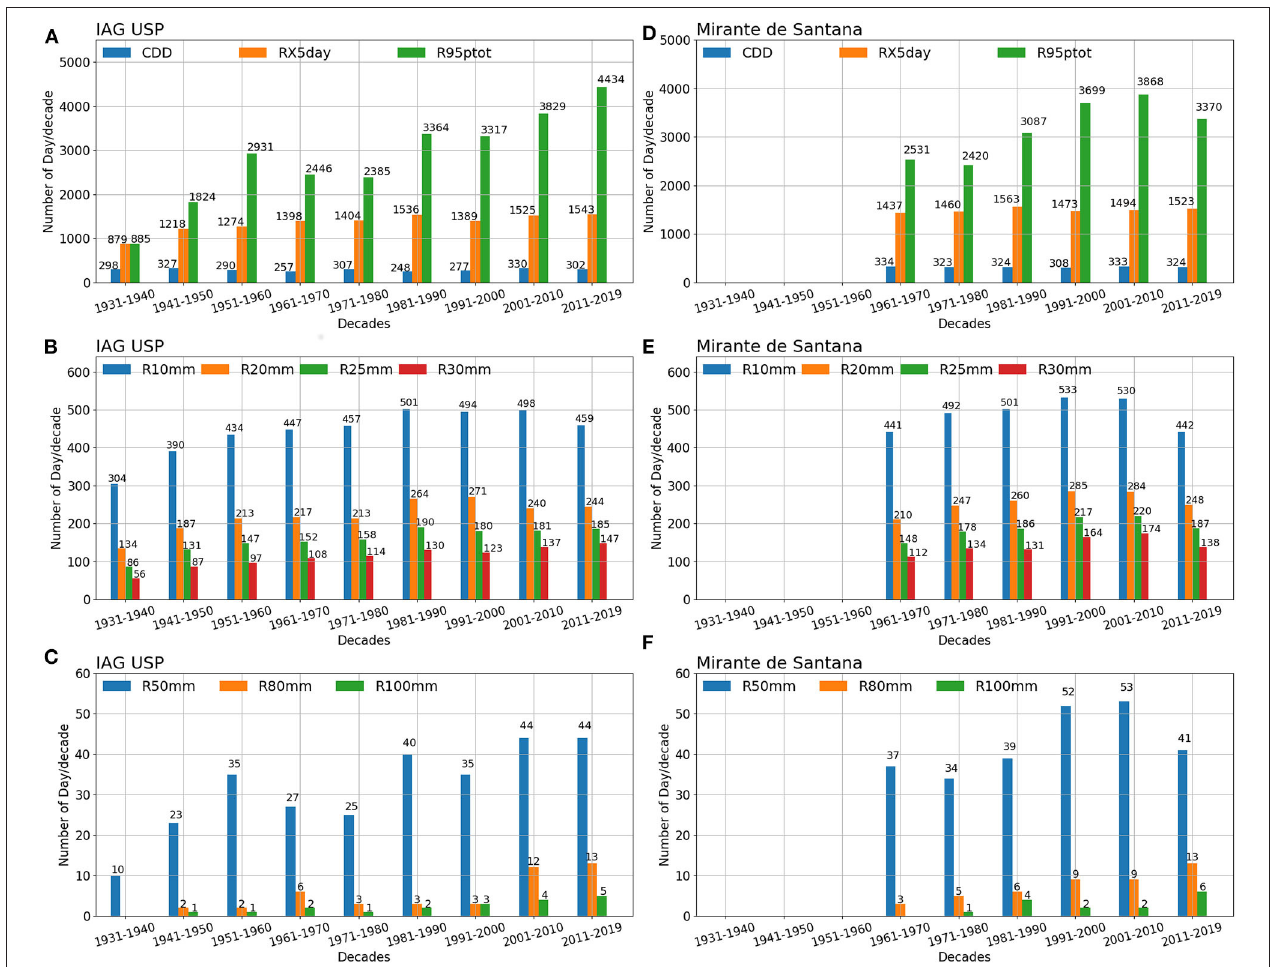
FIGURE 4 | Decadal accumulation of CDD (consecutive dry days), heavy precipitation (R95P), and 5 days accumulated precipitation (R5xD) for (A) IAG-USP and (D) Mirante de Santana; for numbers of days with precipitation above 10mm (R10), 20mm (R20), 25mm (R25), and 30mm (R30) for (B) IAG-USP and (E) Mirante de Santana; and for number of days with precipitation above 50mm (R50), 80mm (R80), and 100mm (R100) for (C) IAG-USP, and (F) Mirante de Santana, with number showing the corresponding decadal numerical